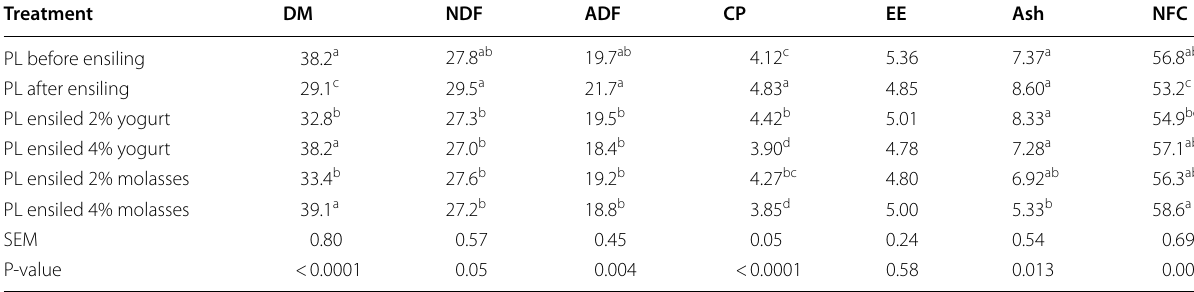
Means within columns followed by the same letter are not different PL pomegranate leaves, DM (% of fresh weight) dry matter, NDF neutral detergent fiber, ADF acid detergent fiber, CP crude protein, EE ether extract, NFC non-fiber carbohydrate SEM standard error of the mean